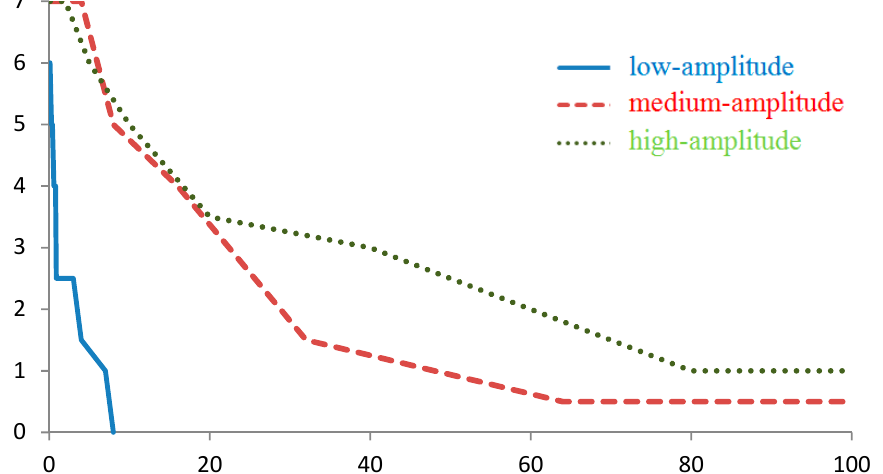
Figure 7. Dependence of the number N true of the correctly found route points on the measurement error (mGal) for a route containing 7 points when navigating by the intersection of the three projections of the g vector. Regions with low-, medium-, and high-amplitude gravity anomalies.